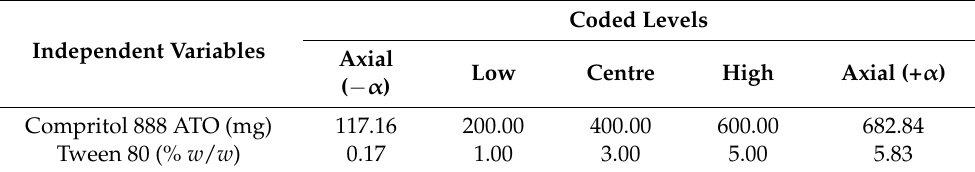
Table 6. Independent variables with high and low